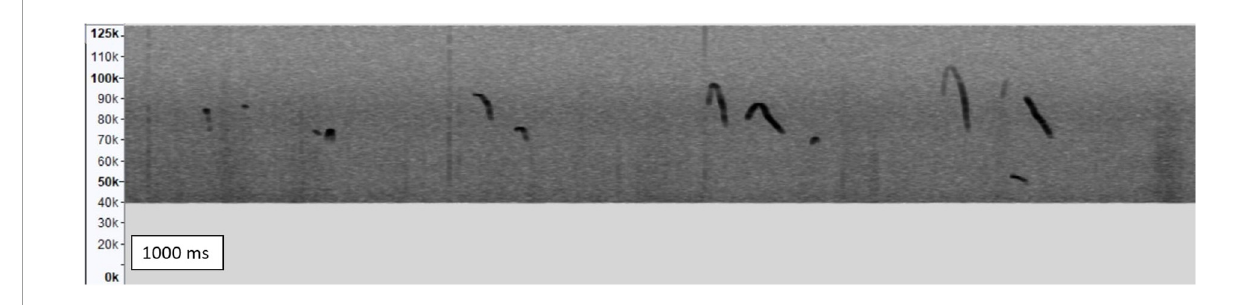
FIGURE2 Exemplary spectrogram of ultrasonic vocalizations emitted by pups. Frequency (Hz) is shown on the y-axis over a fixed time of 1,000 ms on the